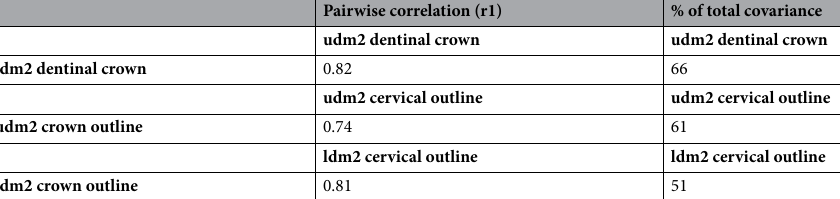
Pairwise correlation (r1)